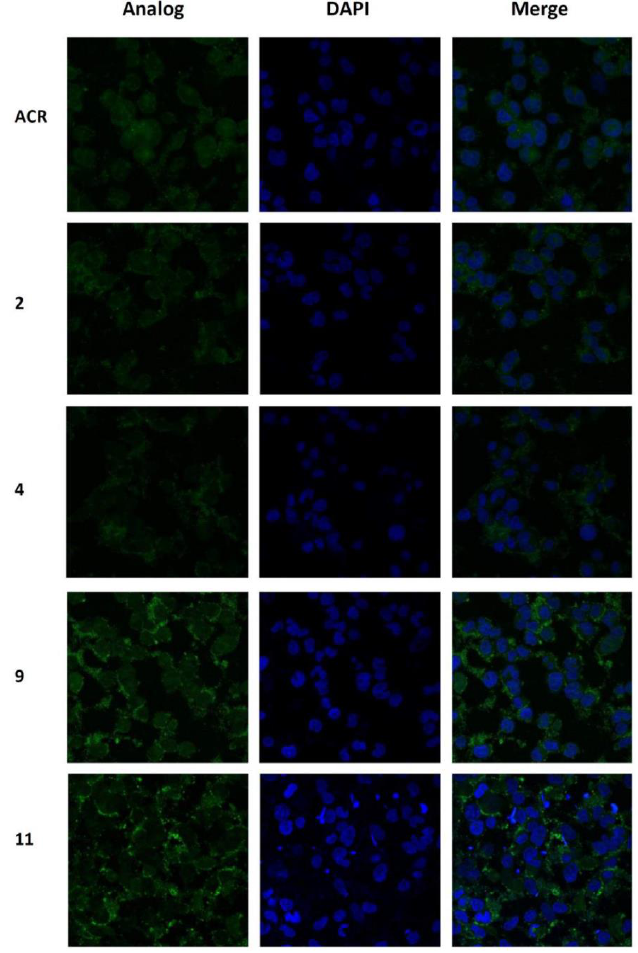
Figure6. Determinationofintracellulardistributionofanalogs 2 , 4 , 9, and 11 inMCF-7breastcancercells. Acridone (ACR) was used as a control. Cells were treated with 1 µ M of each derivative and after 3 h of incubation, cells were imaged by confocal microscopy. Blue is the DAPI (4 (cid:48) ,6-diamidino-2-phenylindole) nuclear